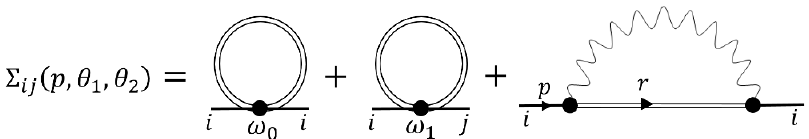
Figure 26. Diagrammatic version of the gap equation. A double line denotes the full matter propagator P ( r; (cid:18) ; (cid:18) ) = (cid:0) 1 , and a wiggly line denotes the full gauge (cid:12)eld propagator 1 2 D 2 + m 0 +(cid:6) obtained in [15] (both propagators are at leading order in 1 =N